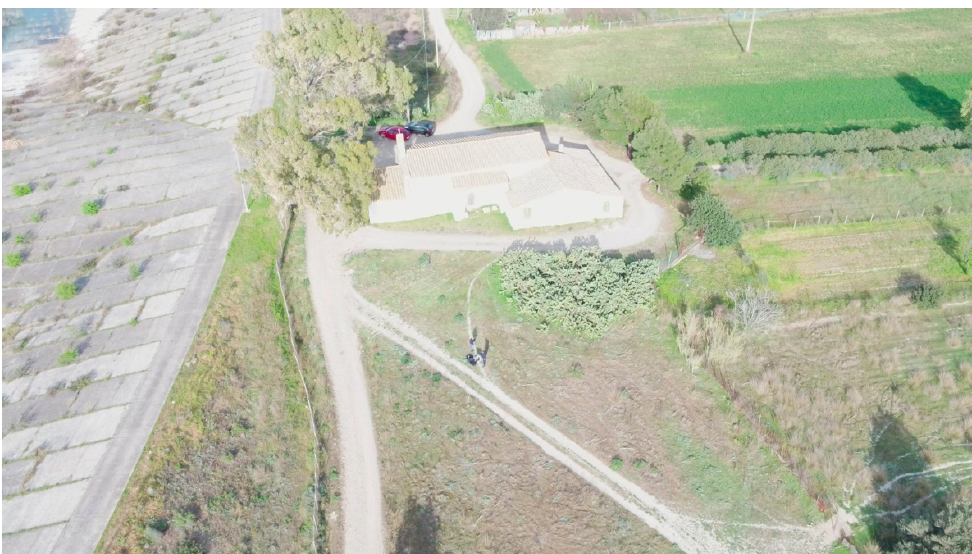
Figure 9. A photo of the operating base, taken from the drone.